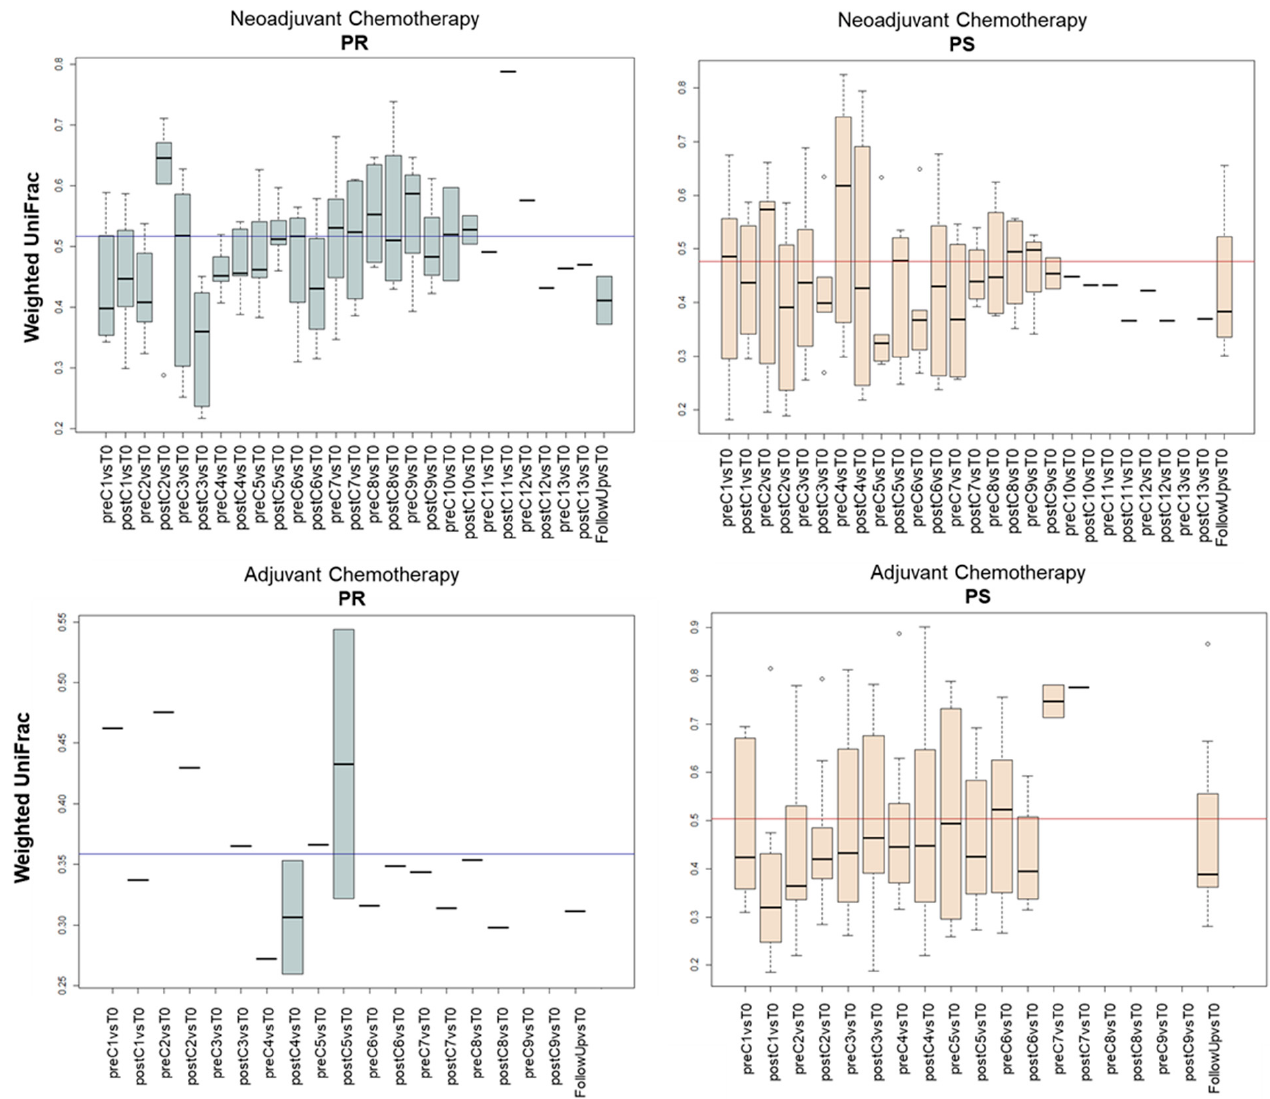
Figure 4. Dynamics of beta diversity in EOC patients during chemotherapy based on therapeutic response. Boxplots show the distribution of weighted UniFrac distances between each time-point and the respective T0 for each EOC patient during neoadjuvant (top) or adjuvant (bottom) chemotherapy. Patients were stratified by response to therapy: PR, platinum-resistant (left) vs. PS, platinum-sensitive (right). The mean inter-patient variability at baseline (i.e., T0) is depicted as a line in each plot. C, chemotherapy cycle.